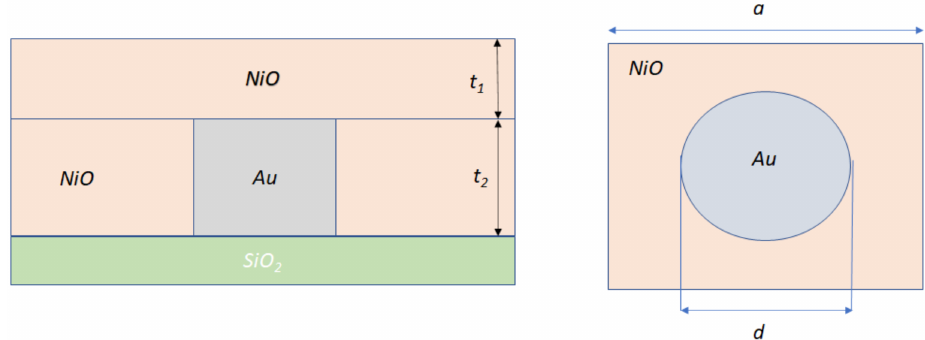
Figure 1. Side and Top view of the AuNiO examined system.